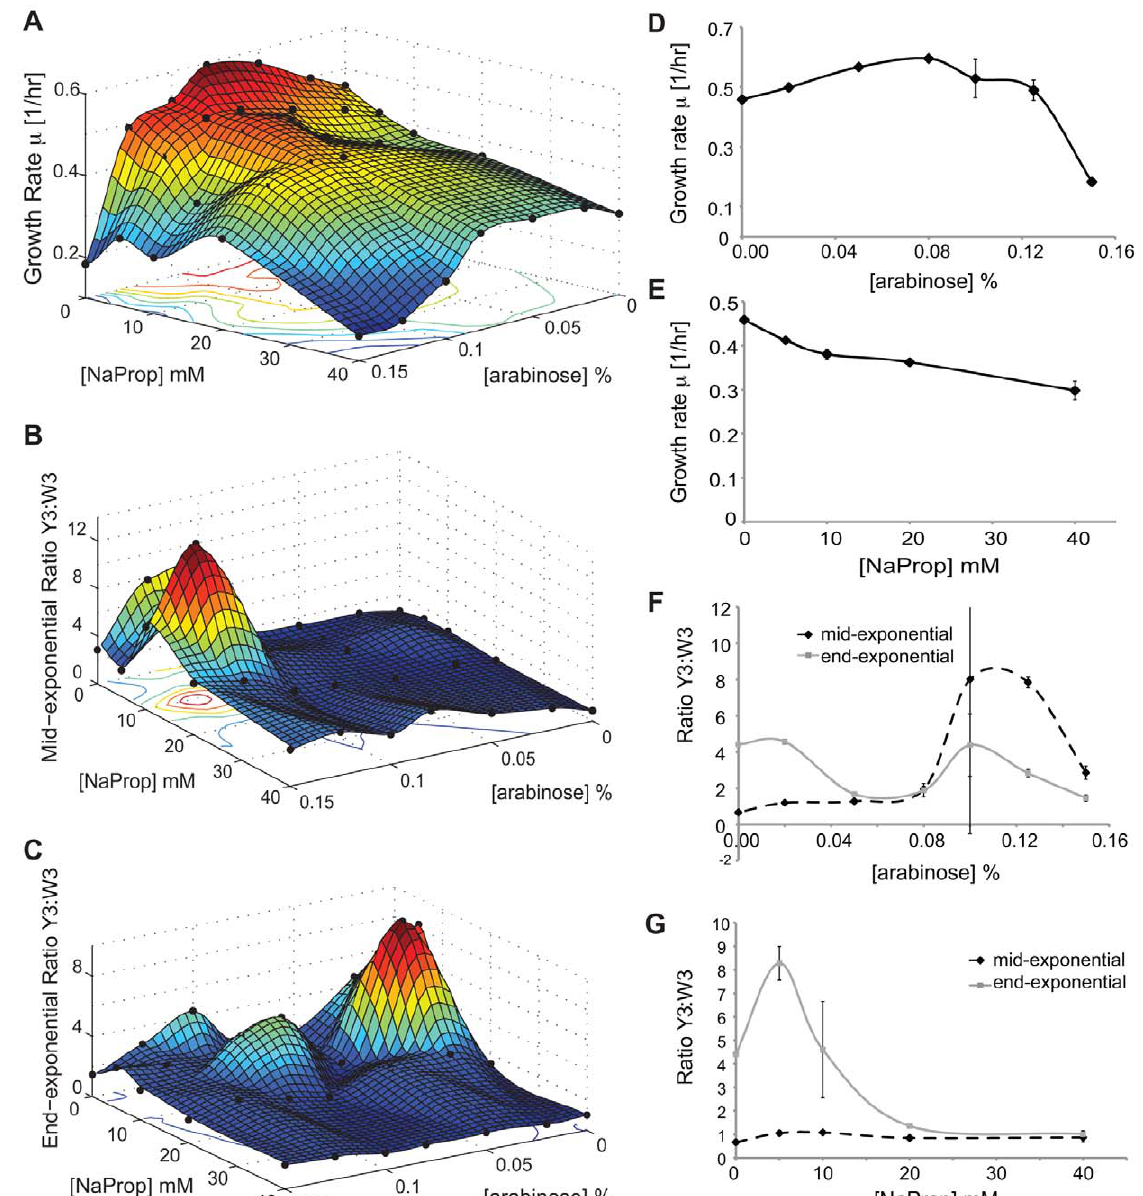
Figure 3. Range of co-culture growth rate and composition regulated by two inducers. Co-culture experiments were conducted over a grid of inducer concentrations. The experimental results (black dots) were then interpolated using Matlab to create a three-dimensional surface. Range of co-culture growth rate ( A ), mid-exponential Y3:W3 ratio ( B ), and end-exponential Y3:W3 ratio ( C ) that can be achieved using this circuit. ( D, E, F, G ) Edges of the 3D surfaces. Effect of tuning arabinose and propionate on the growth rate ( D, E ) and Y3:W3 ratios ( F, G ). ( D, F ) 0 mM propionate ( E, G ) 0% arabinose. Both the mid-exponential and end-exponential ratio were determined using the YFP calibration. Experimental data are given in Data S1. doi:10.1371/journal.pone.0034032.g003 Figure S6A&B). For both arabinose and propionate, the two- two contour plots (see Methods for details). For achieving a specific dimensional contour plot has both ‘‘steep’’ areas featuring tight growth rate and end-exponential ratio combination, Figure 5A contour lines, where substantially varying the inducer concentra- and Figure 5B show what arabinose and propionate concentra- tion is required to change the growth/ratio, and almost ‘‘flat’’ tions shall be used, respectively. Similarly, Figure S6A&B can be regions, where small changes of inducer concentration correspond used to determine the inducer concentrations for achieving a to large changes of growth/ratio. Additionally, higher concentra- specific growth rate and mid-exponential ratio combination. Due tions of arabinose appear to produce lower end-exponential ratios to the high nonlinearity of the dependence of growth rate and and variable growth rate, while higher propionate concentrations strain ratio on inducer concentrations (Figure 3), the design spaces are also very nonlinear and exhibit irregular shapes (Figure 5A&B,